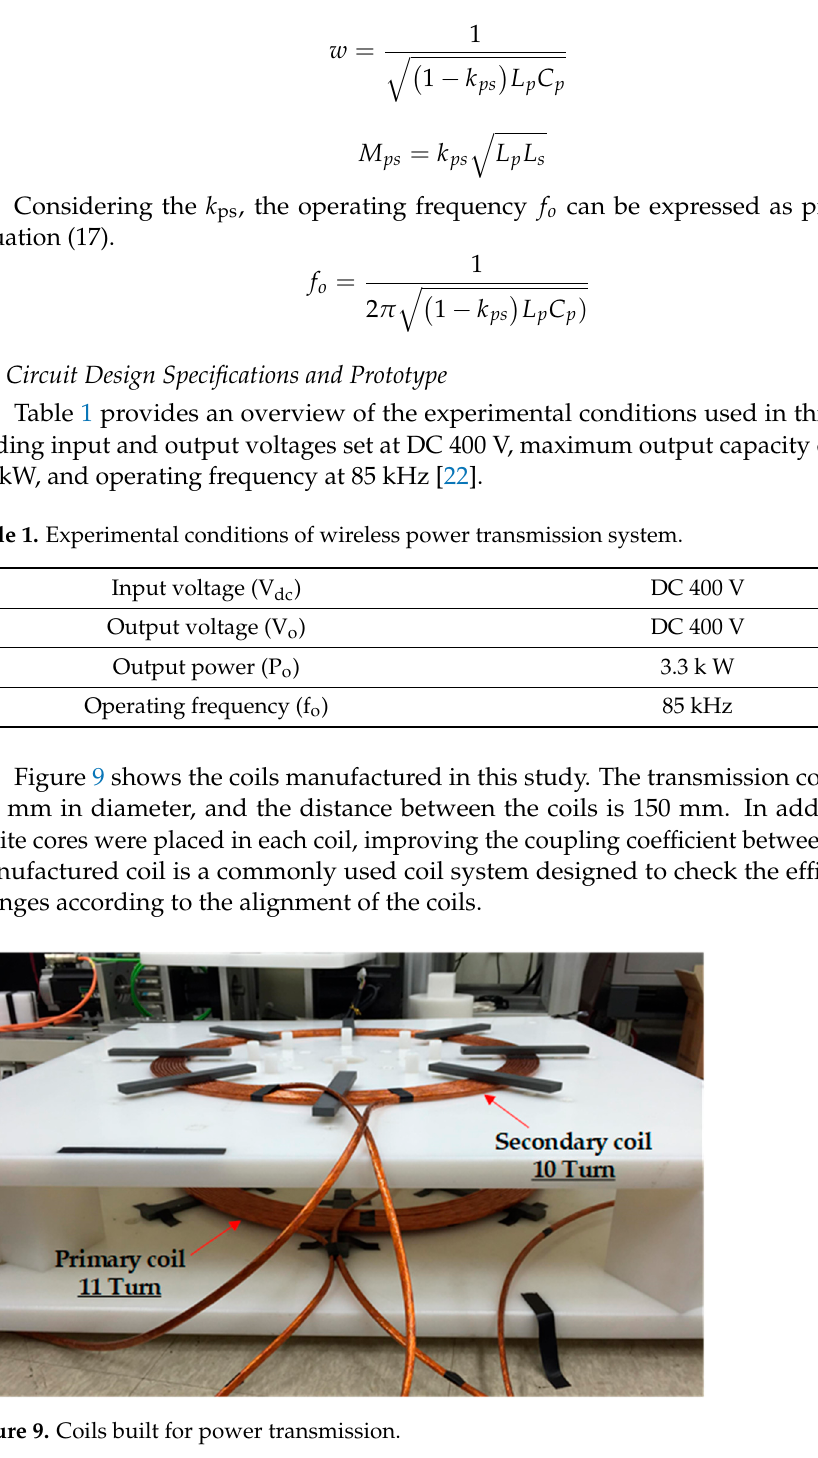
Table 2. Design speci fi cations of the wireless power transfer system for the experiment.